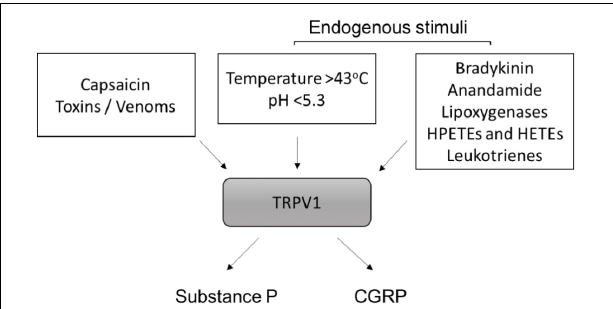
FIGURE 3 | Activation of TRPV1 and neuropeptide release. Exogenous and endogenous stimuli that activate TRPV1 are shown. HPETEs (hydroperoxyeicosatetraenoic) and HETEs (hydroxyeicosatetraenoic) refer to eicosanoid derivatives of arachidonic acid. Once activated, TRPV1 on sensory C-fibers releases substance P and calcitonin-gene related peptide (CGRP) from nerve endings.